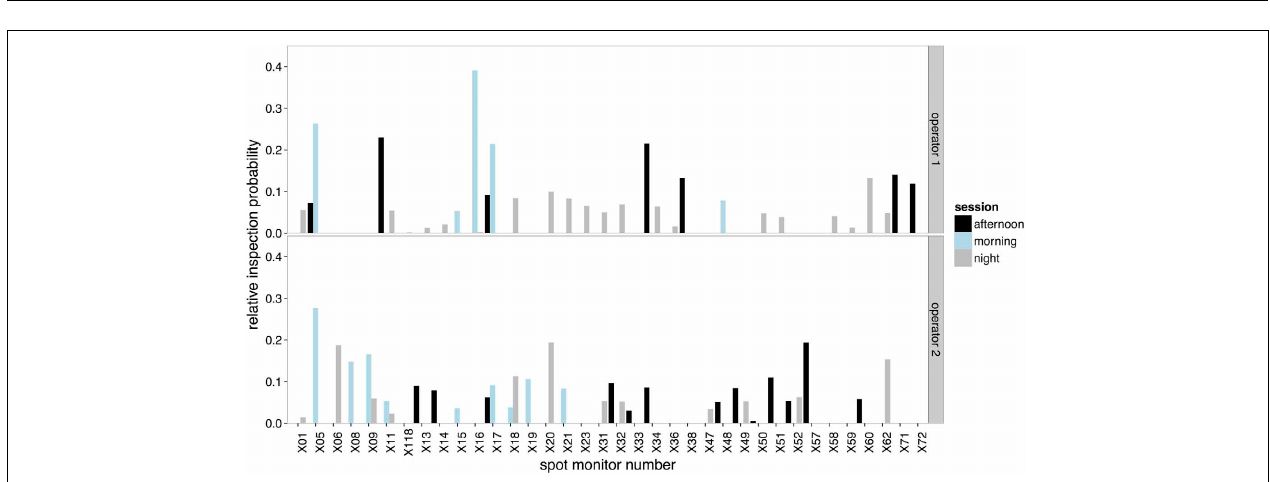
the morning and night session with no looks at the multiplex—hence lack of ± SE). (C) Mean length of each spot monitor scanning session. (D) Mean scanning time per scene on the spot monitor (with ± SE).